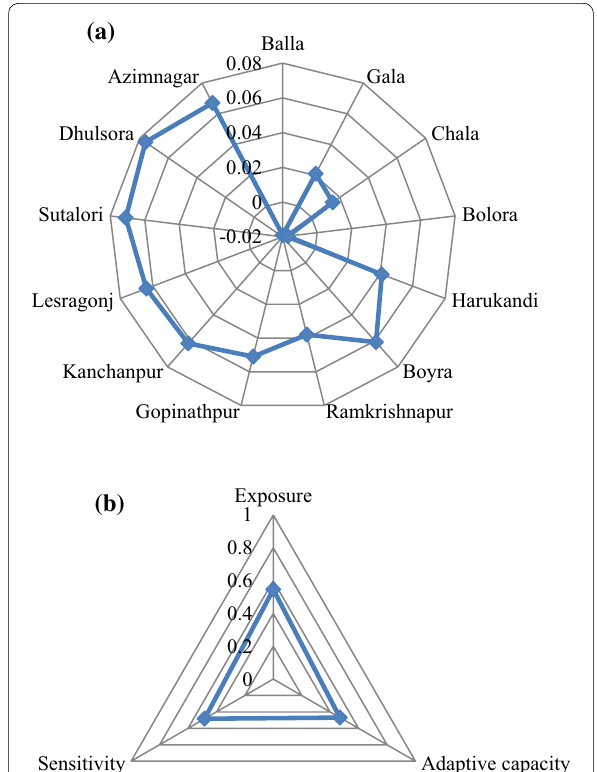
Fig. 5 a Spider diagram showing the union‑wise vulnerability index, and b triangular diagram showing the contributing factors of the IPCC‑VI of the study